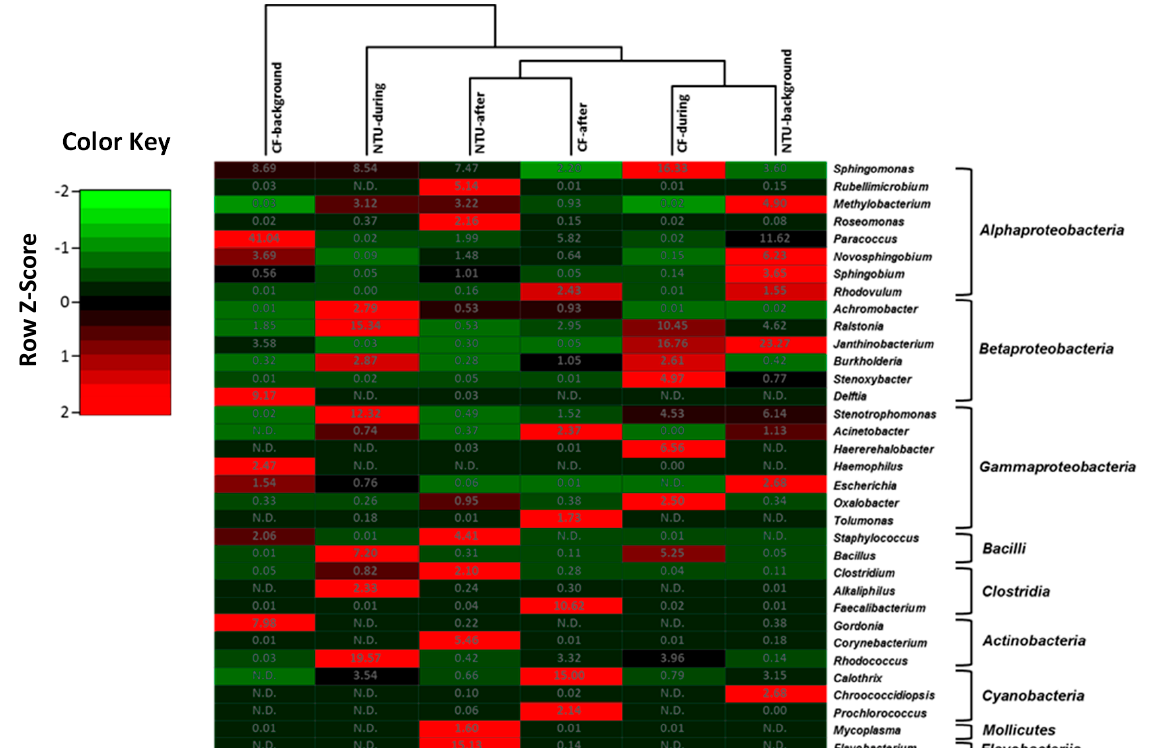
Figure 4. Heat map displaying the similarity among bacterial community structures in samples collected on background days as well as during and after the FP1 (frontal pollution case 1) based on the sequence frequencies of the top 10 genera. The numbers in the heat map refer to the relative abundance (%) of all genera in a specific sample. The color key shows the standard deviations of sequence frequency from the mean, with light green depicting low frequency and light red depicting high frequency. The genera with the relative abundance of less than 1% were not listed.